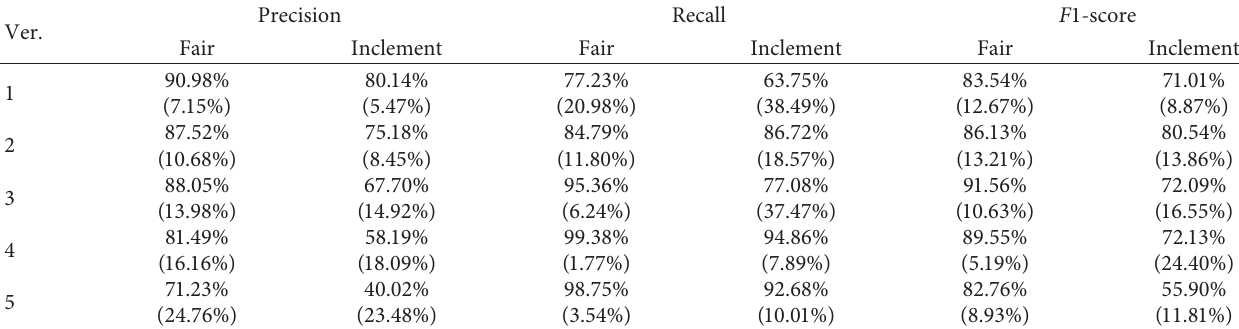
Table 3: Version-specific parameter values (i.e., mean and standard deviation) at different weather conditions.